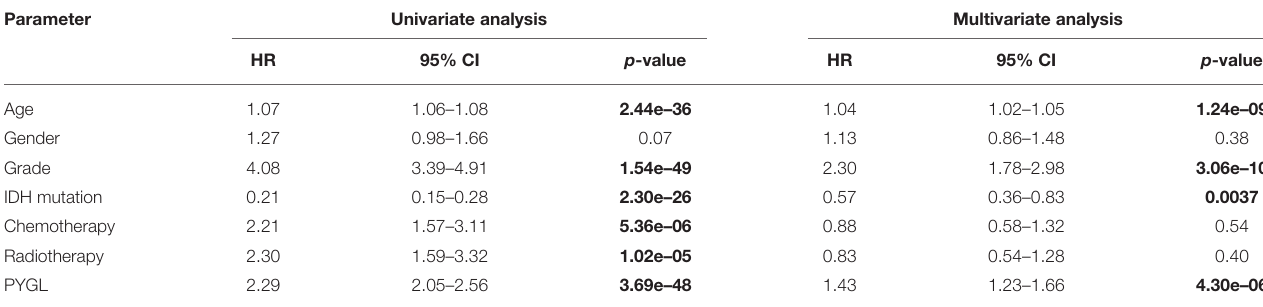
TABLE 2 | Univariate analysis and multivariate analysis of the correlation between PYGL expression with OS among glioma patients.